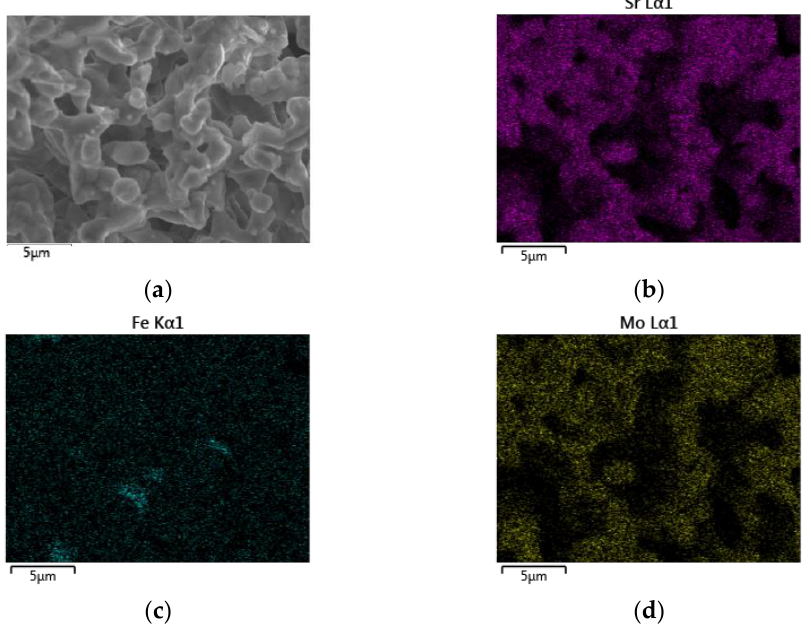
Figure 8. EDS mapping for a section of the sample E after the reduction process ( a ). A homogeneous distribution of strontium ( b ) and molybdenum ( d ) atoms can be observed while a non-uniform distribution of iron ( c ) atoms is obtained.